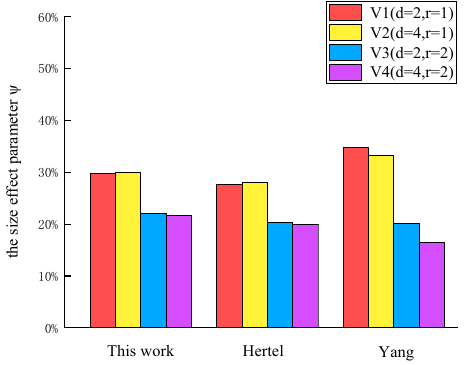
Figure 12. Size effect parameter ( ψ ) for different notched specimens.